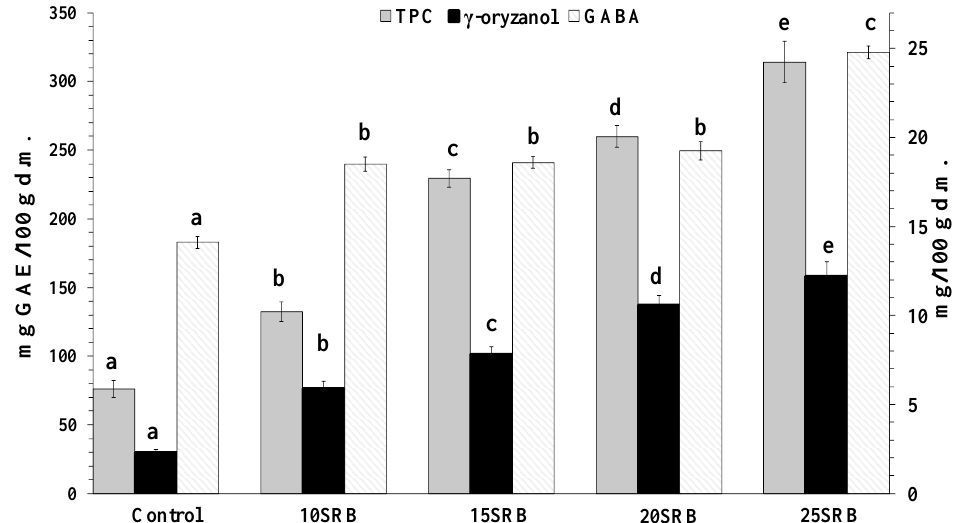
Figure 2. Total phenolic compounds (mg GAE/100 g d.m.), γ -oryzanol (mg/100 g) and GABA (mg/100 g) content in white wheat bread with stabilized rice bran (SRB) (n = 3). Abbreviations: 10SRB, formulation with 10% of SRB; 15SRB, formulation with 15% of SRB; 20SRB, formulation with 20% of SRB; 25SRB, formulation with 25% of SRB. The different lowercase letters indicate significant difference among mean values within a same compound ( p ≤ 0.05 according to Duncan’s test).